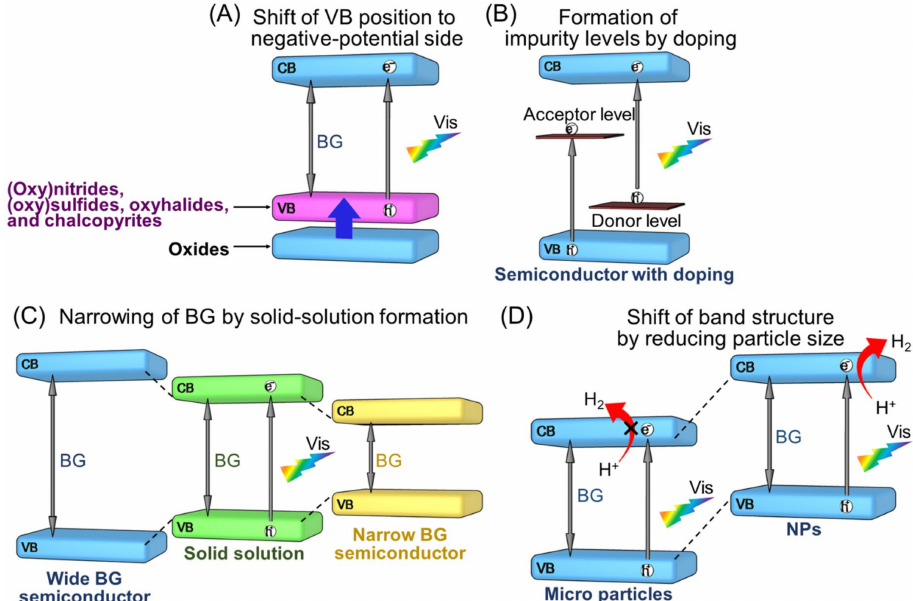
Figure 6. Schematic illustrations showing strategies for obtaining Vis-light-driven water-splitting photocatalysts. ( A ) Shift of VB position to negative-potential side, ( B ) formation of impurity levels by doping, ( C ) narrowing of BG by solid-solution formation, and ( D ) shift of band structure by reducing particle